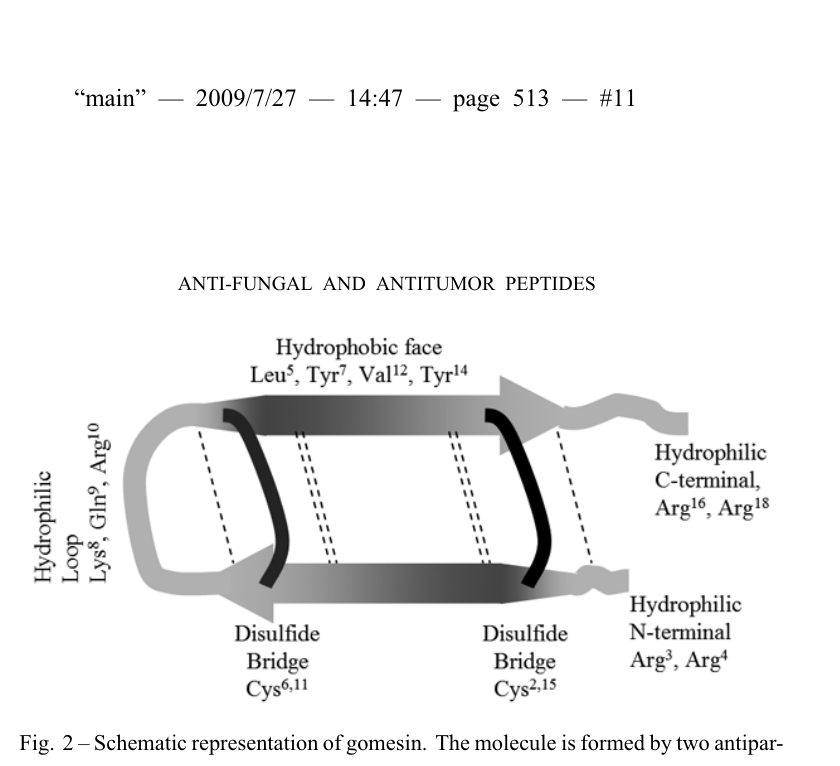
Fig. 2 – Schematic representation of gomesin. The molecule is formed by two antipar- allel β -strands stabilized by 2 disulphide bridges (black lines) and 6 hydrogen bounds (hatched lines). Gomesin contains a hydrophobic face and three hydrophilic regions.